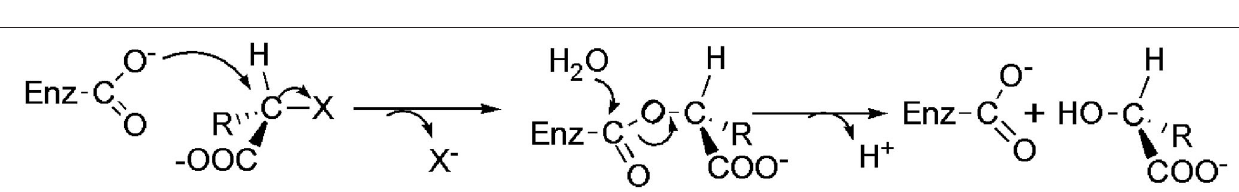
FIGURE 2 | Reaction mechanism of L-DEX (Schmidberger et al.,